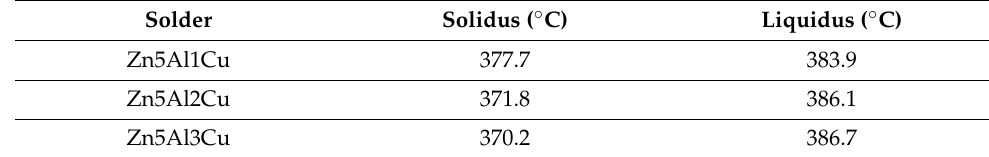
Figure 7. The phase diagram of Al–Zn–Cu for the concentration of 3 wt. % Cu [20]. Table 3. Solidus and liquidus temperatures of Zn-Al-Cu